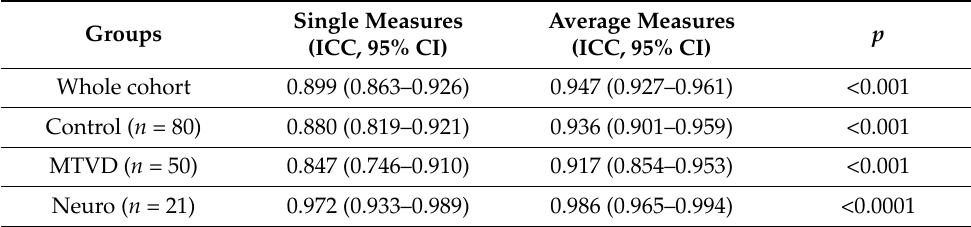
Table 3. Reliability of PD testing. ICC: intraclass correlation coefficient; CI: confidence interval, MTVD: muscle tension voice disorders.